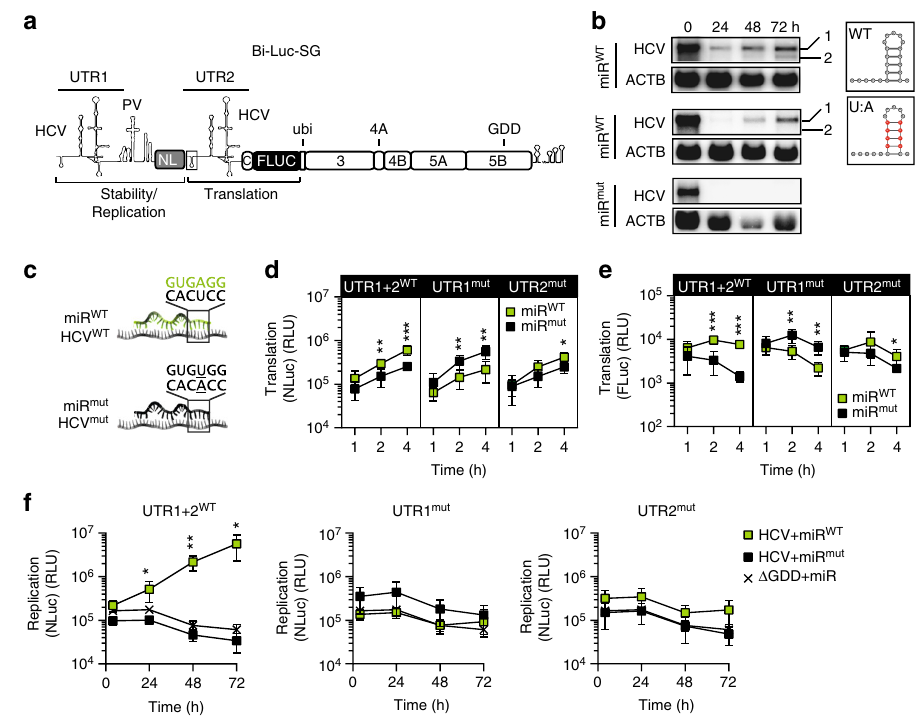
Fig. 2 Dissection of stability and replication using a dual-luciferase replicon. a Illustration of the Bi-Luc-SG construct. miR-122 binding to UTR1 acts on RNA stability and replication (as measured by Nano luciferase activity), translation of non-structural proteins is driven by UTR2 (as measured by fi re fl y luciferase activity). b Northern blot analysis of HCV RNA stability over 72 h. Stability of different Bi-Luc construct RNAs was analyzed in the presence of miR mut or miR WT . Band #1: full-length RNA, #2: truncated product. U:A mutations in SLI of UTR2 (red dots) prevented the formation of truncated RNA. c Illustration of miR WT (green) and miR mut (black) binding upon introduction of a matching point mutation in the target (underlined). d , e Translation assay of point mutants cloned into the MBR of UTR1 or 2. The activity of Nano ( d ) and fi re fl y ( e ) luciferase was measured in the presence of miR mut or miR WT . f Assessment of the full intracellular replication cycle of the Bi-Luc-SG constructs after electroporation with miR mut or miR WT . Replication was monitored with the nano luciferase signal. Mean values (±SD), n = 3, duplicates. RLU relative light units, Δ GDD replication de fi cient mutant. For translation, statistical signi fi cance was determined for miR WT against miR mut , for replication miR WT and miR mut conditions were tested against Δ GDD. * P <0.05, ** P <0.01, *** P